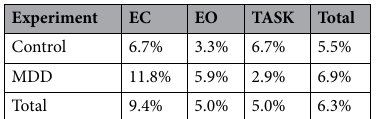
Table 2. Summary of missing data for MDD